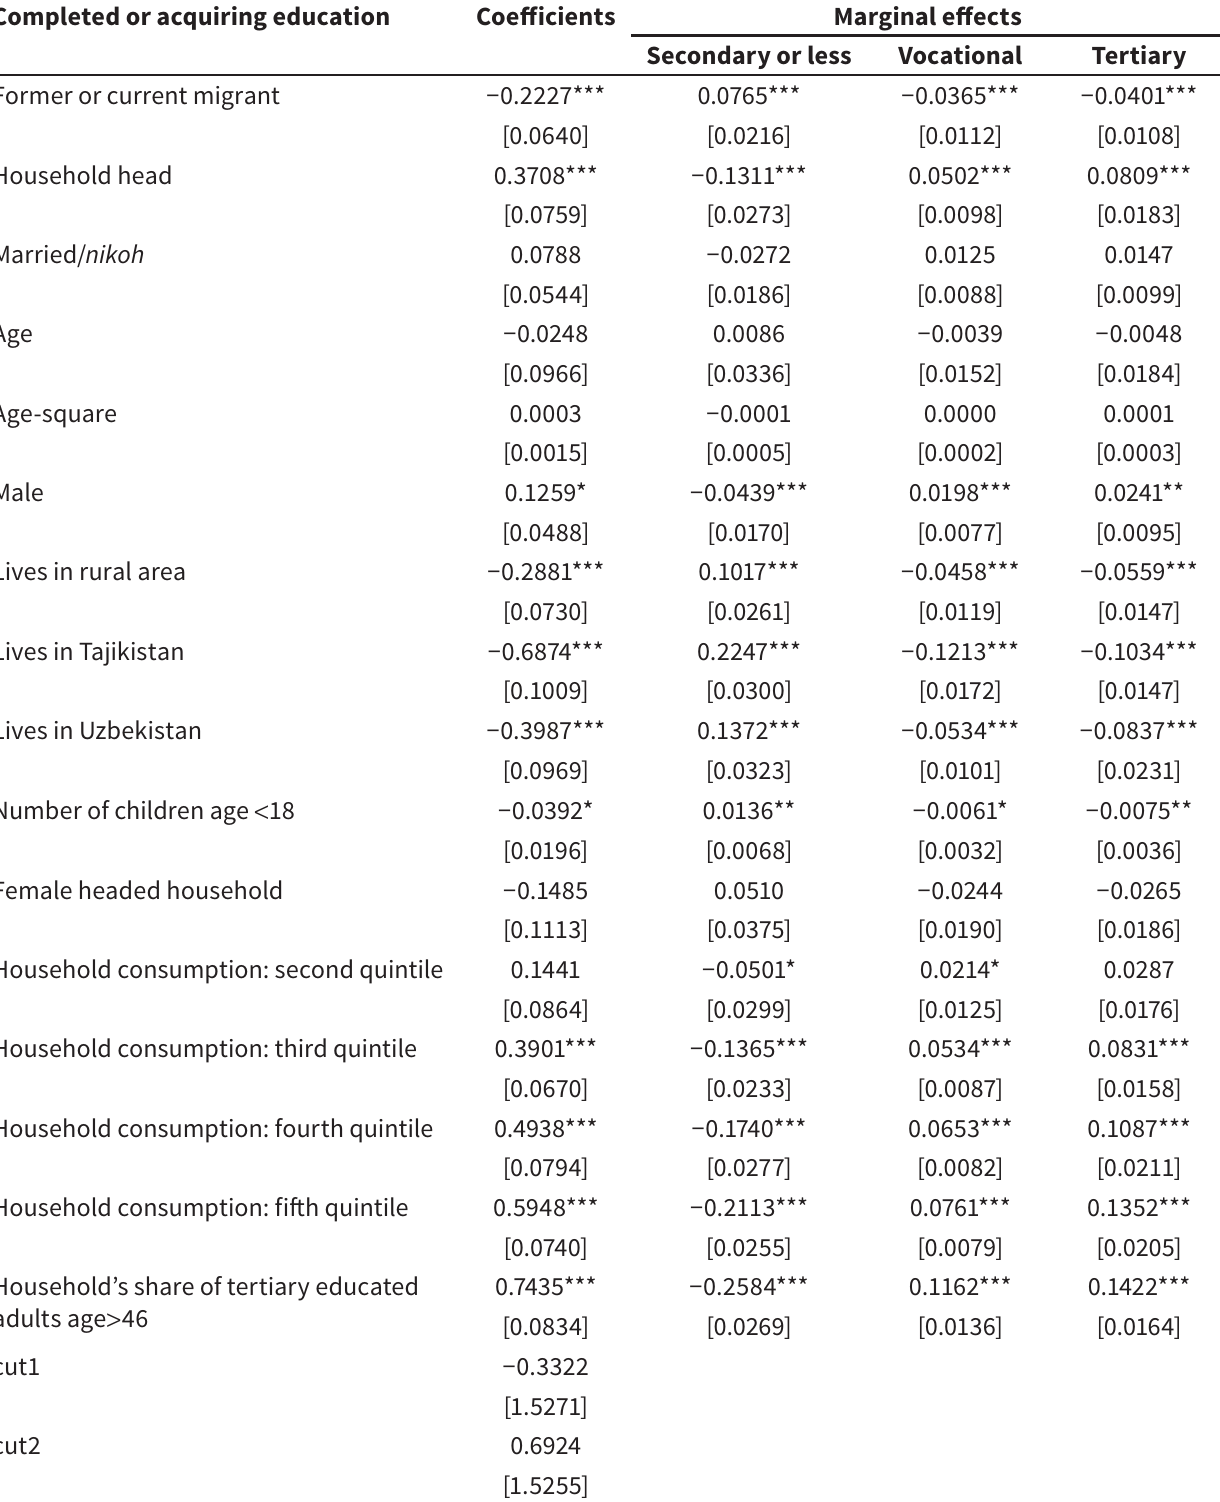
Ordered probit of the choice of